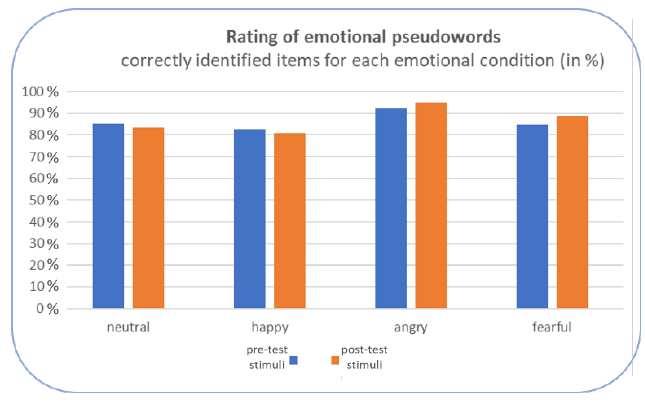
Figure 2. Results of the online rating of the acoustic stimuli.